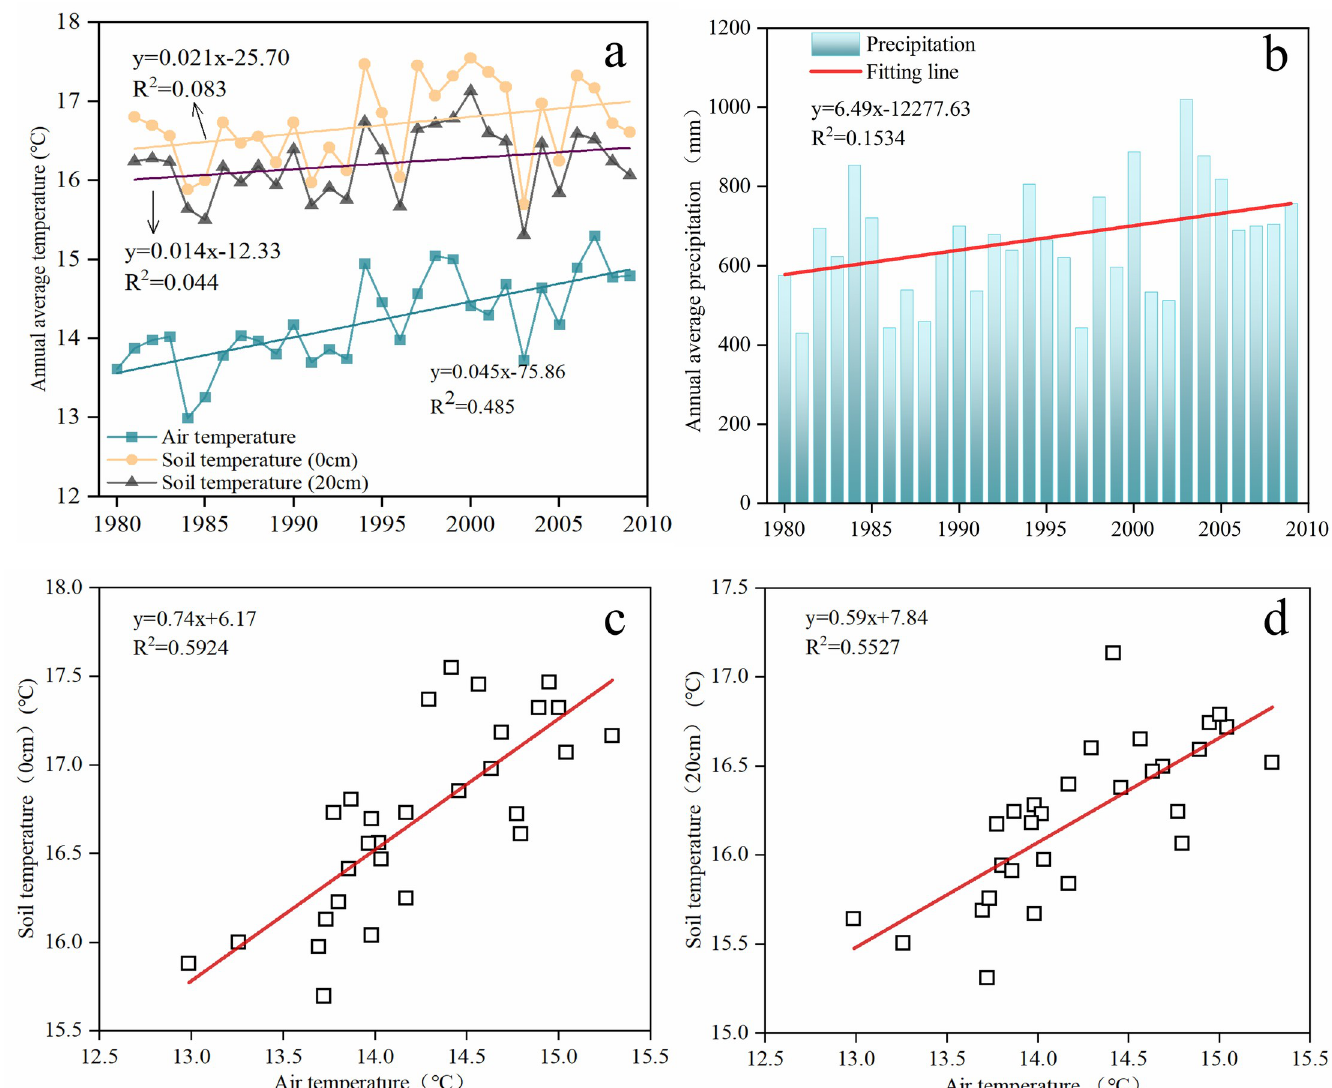
Fig 6. The climatic factors of the study area. a. Interannual variation of air temperature and soil temperature. b. Interannual variation of precipitation. c.d. Correlation between air temperature and soil temperature in the study area.